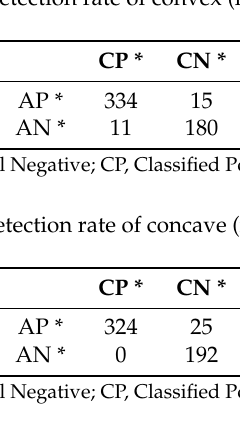
Table 2. Detection rate of convex (nighttime).